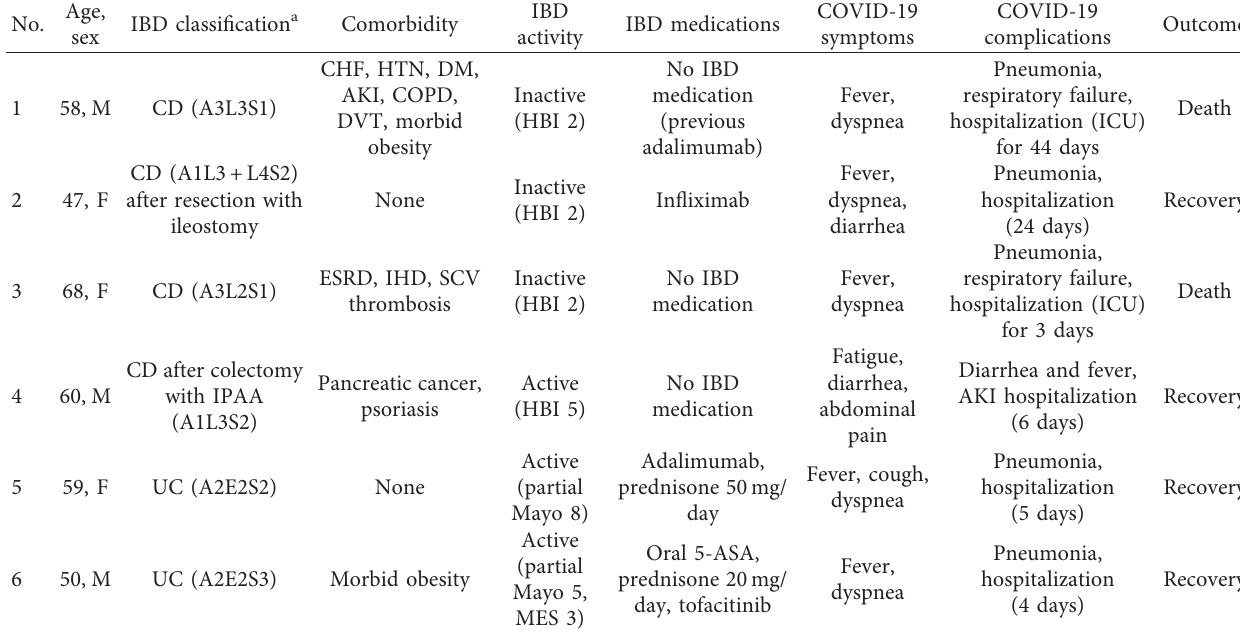
a IBD classification by Montreal classification. CD: Crohn’s disease, UC: ulcerative colitis, HBI: Harvey-BradshawIndex, SES-CD: Simplified Endoscopic activity Score for Crohn’s Disease, MES: Mayo endoscopic score, AKI: acute kidney injury, COPD: chronic obstructive pulmonary disease, CHF: congestive heart failure, DVT: deep vein thrombosis, DM: diabetes mellitus, ESRD: end-stage renal failure, HT: hypertension, IHD: ischemic heart disease, SCV: subclavian vein, 5-ASA: 5-aminosalicylic acid, ICU: intensive care unit